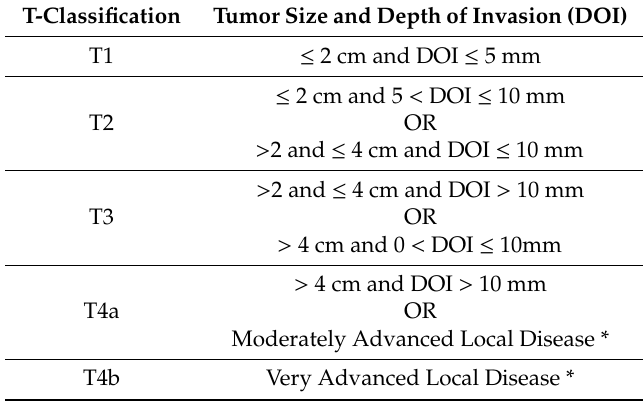
Table 1. Tumor staging of oral cavity squamous cell carcinoma per AJCC8 guidelines. T-Classification